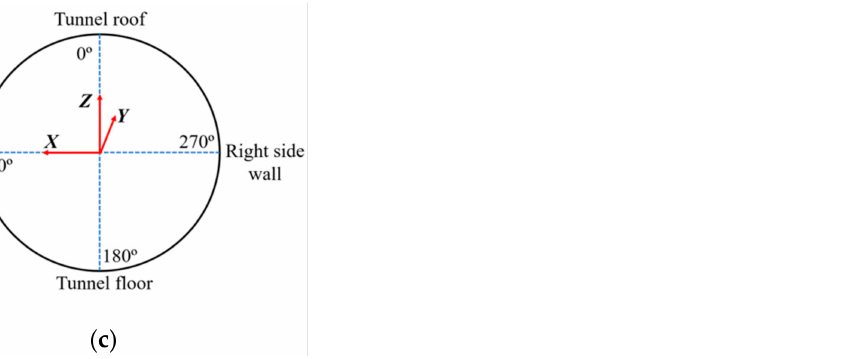
Figure 1. Equipment for experiment ( a ) apparatus; ( b ) model dimension; ( c ) cross-section of lining.